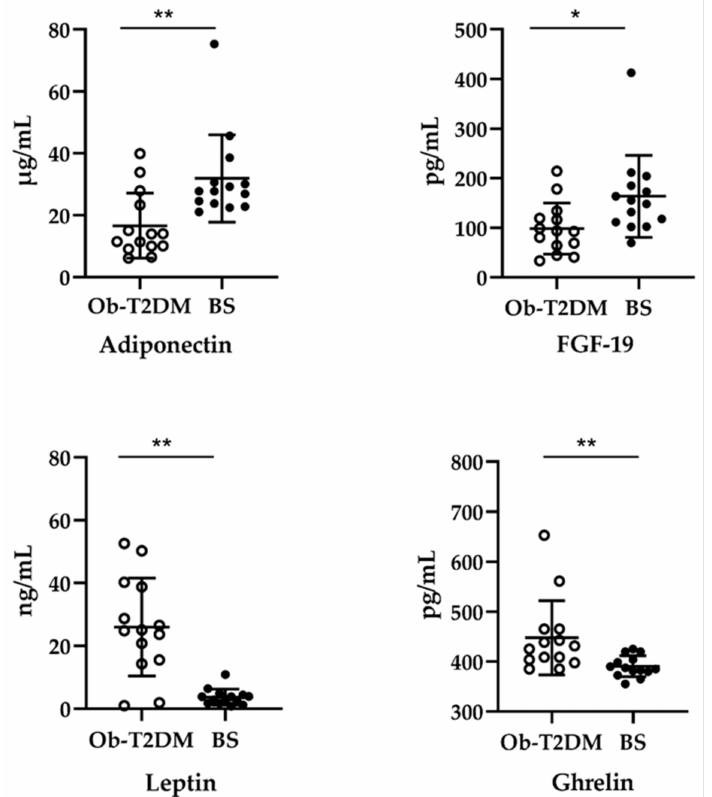
Figure 2. Adiponectin, leptin, ghrelin, and FGFG-19 level in obese type 2 diabetes mellitus [Ob-T2DM; n = 14] patients before and after bariatric surgery [BS; n = 14]. Biomarkers levels were measured in the serum of patients and were compared between groups. p -values were calculated using the Mann–Whitney test. * p < 0.05; ** p <